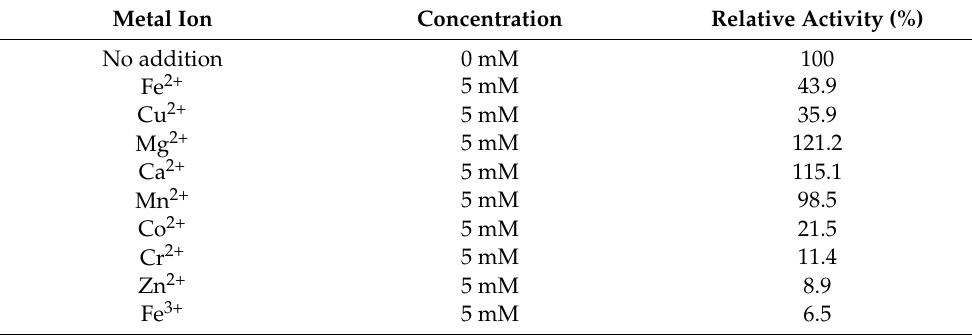
Table 2. The effect of metal salts and chemical agents on the activity of free CDA. Metal